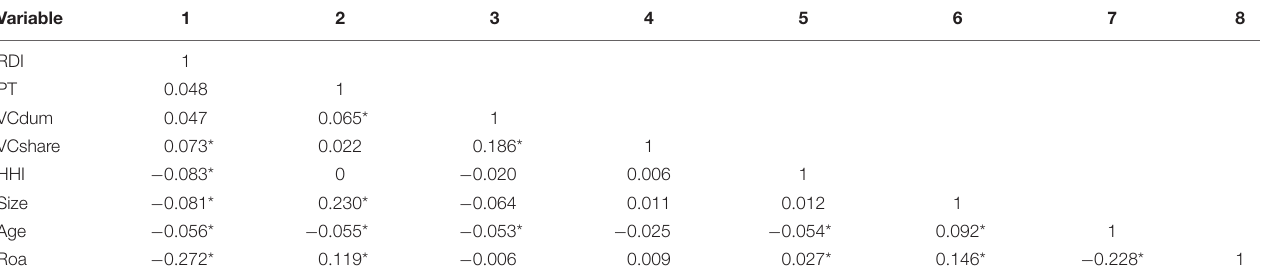
TABLE 4 | Correlation coefficient regression results of main variables ( n = 2535). Variable